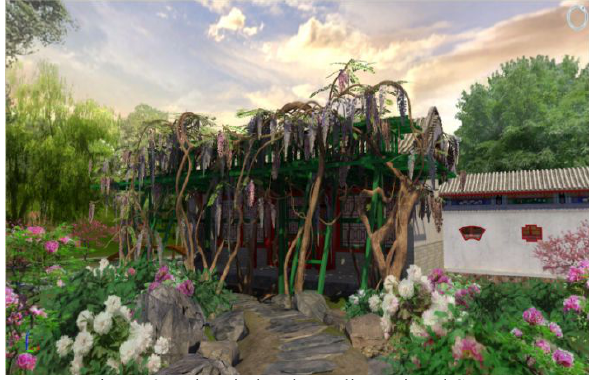
Figure 9. Wisteria in Three-dimensional Scene